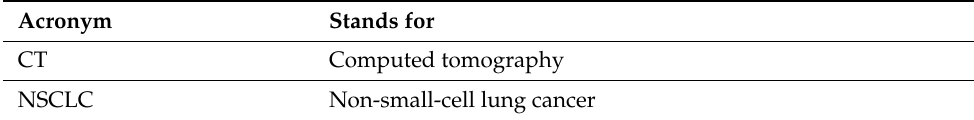
Table A2. Recap of all the acronyms and their